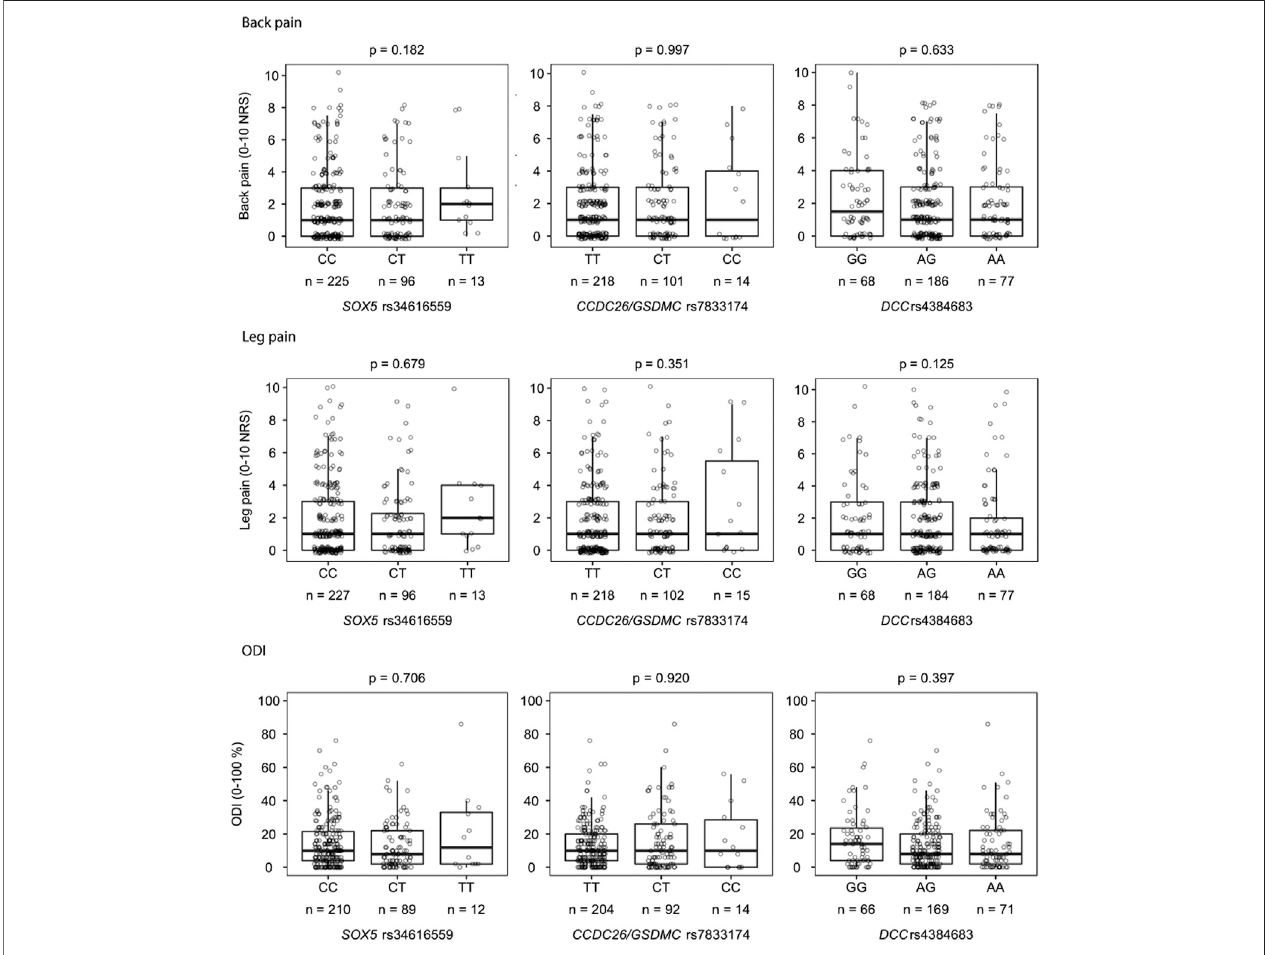
FIGURE 2 | Associations between each genotype (3 allele groups) of the selected SNPs ( SOX5 rs34616559 , CCDC26/GSDMC rs7833174 and DCC rs4384683 ) and each outcome measure (back pain (A) , leg pain (B) and ODI (C) ) analyzed with Kruskal-Wallis H test. Missing data: Back pain ( n = 3), leg pain ( n = 1), ODI ( n = 26). ODI; Oswestry disability